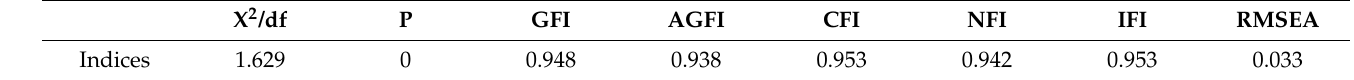
Table 3. Model fit indices.